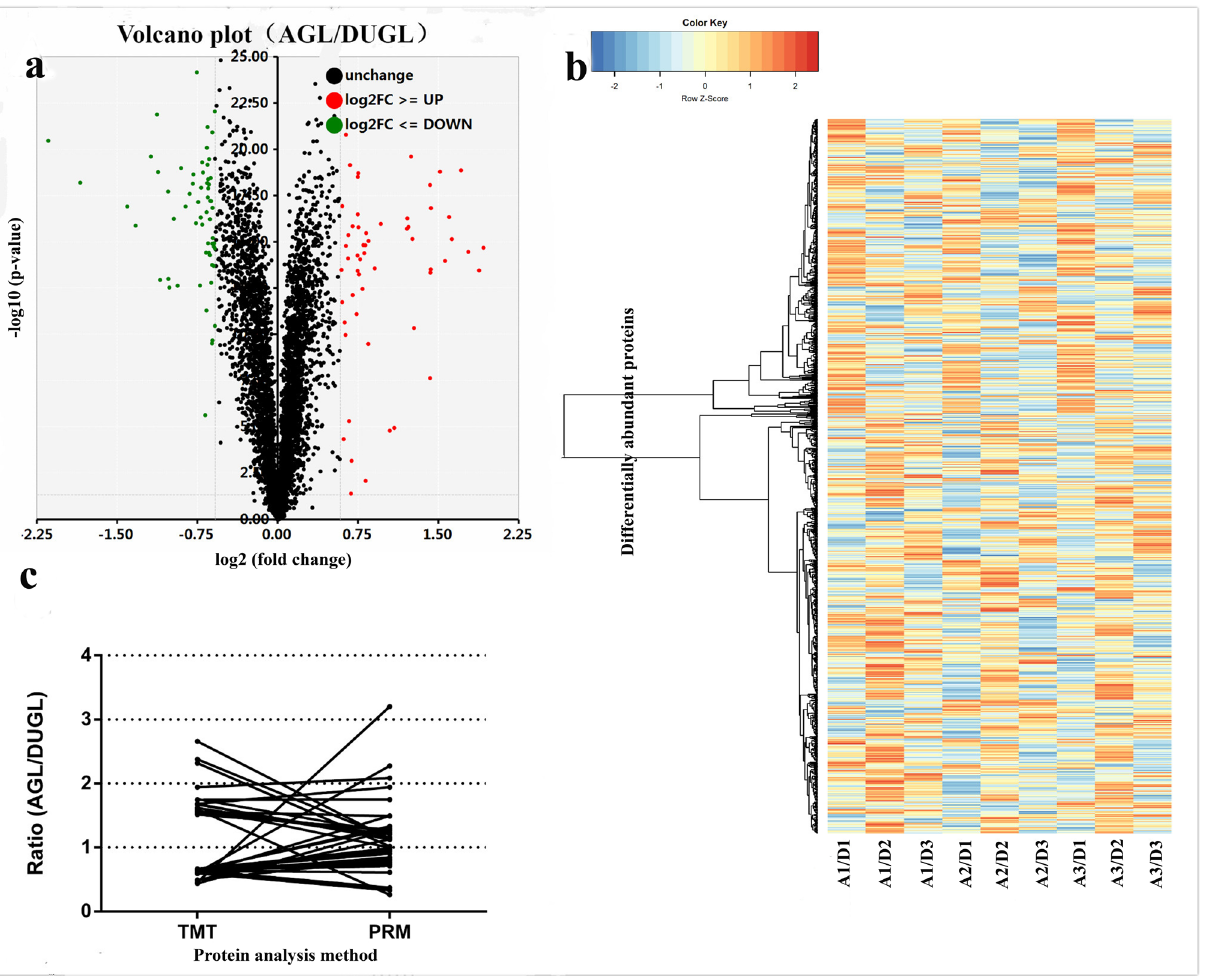
Figure 5. Volcano plot (red, up-regulated DAPs; black, unchanged DAPs; green, down-regulated DAPs [AGL/ DUGL]) ( a ) and hierarchical cluster (white, unchanged DAPs; bright red, over-expression of DAPs [AGL/ DUGL]) of DAPs in V79 cells cultured in the DUGL( b ). Verification analysis shows selected DAPs verified by PRM (AGL/DUGL) ( c ). DAP, differentially abundant proteins; DUGL/D, deep underground laboratory; AGL/A, above ground laboratory; PRM, parallel reaction monitoring. The X-axis of ( c ), the DAPs of